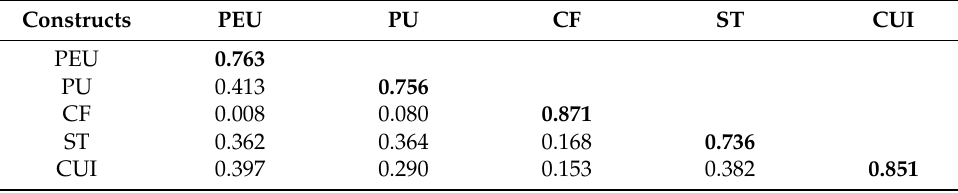
Table 5. Correlation matrix and discriminant validity